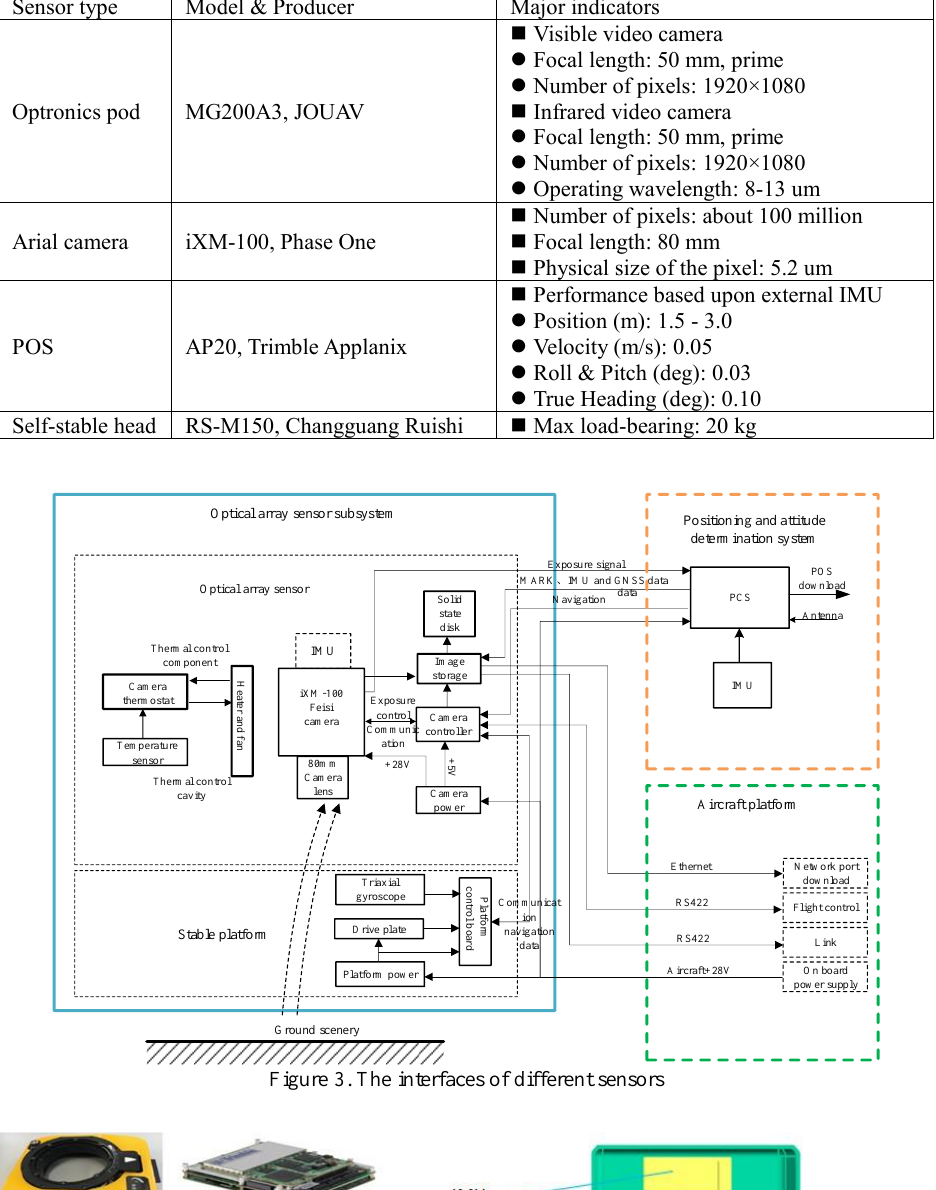
Table 1. Major indicators of selected sensors